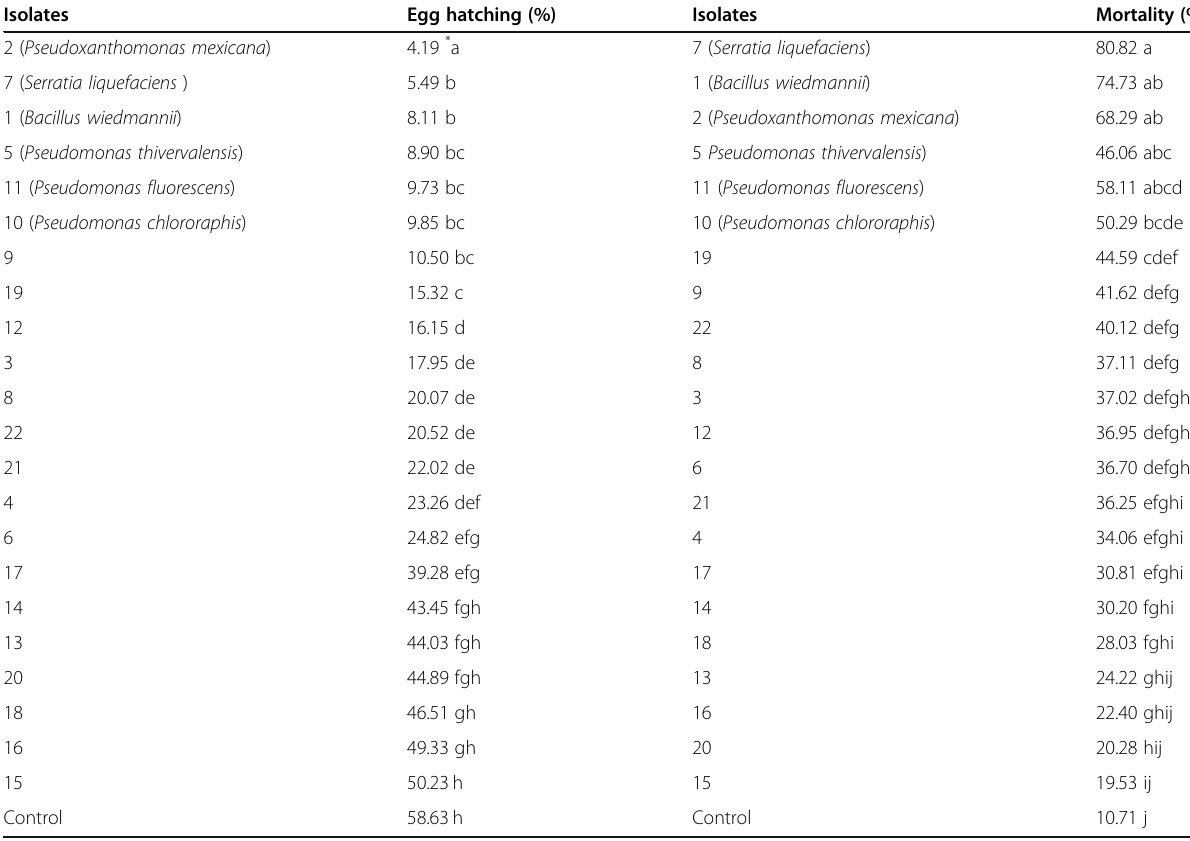
Table 2 Mean comparison of percentage of egg hatching and mortality of J 2 s in bacterial isolates Isolates